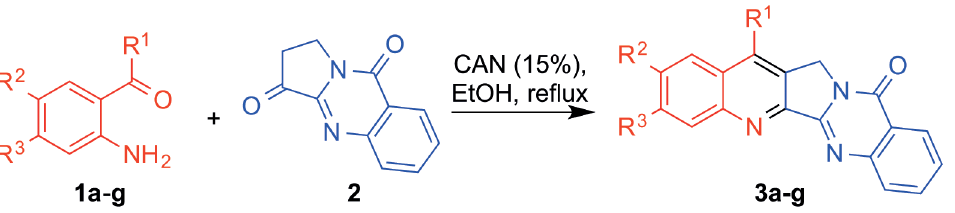
Figure 3. Synthesis of luotonin A and its analogues by CAN-catalyzed Friedla¨nder reactions. The reaction between the o -aminocarbonyl compounds 1 and the dehydrovasicinone 2 was performed in refluxing ethanol, in the presence of Ce(IV) ammonium nitrate (CAN) as a Lewis acid.